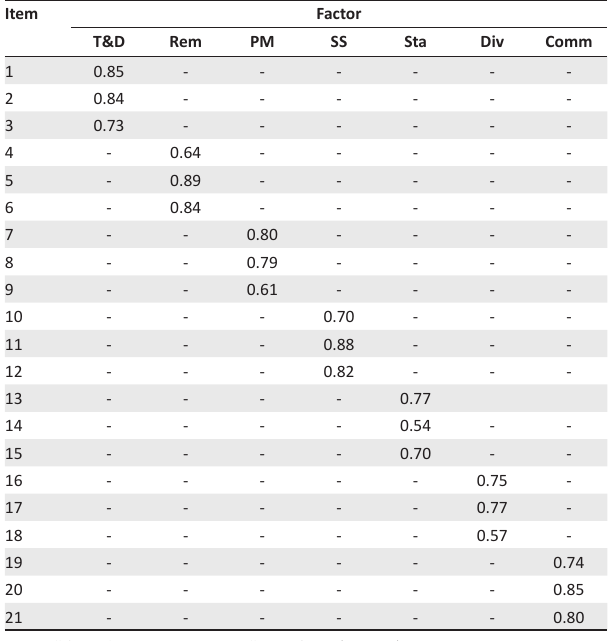
TABLE 3: Standardised factor loadings of the Human Resource Practices Scale items for men and women jointly.